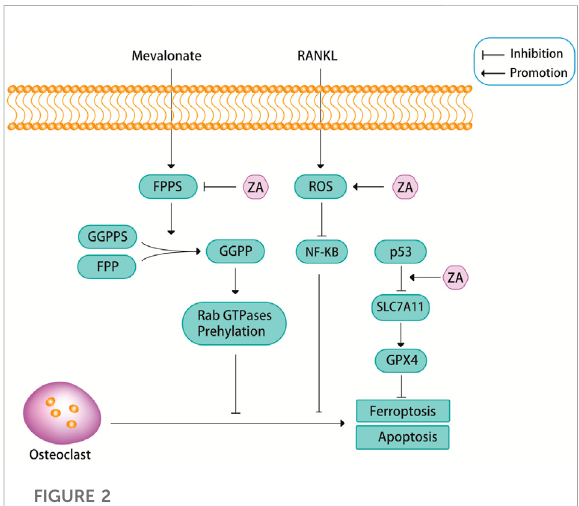
FIGURE 2 ZAcaninhibitthemevalonatepathway.Farnesylpyrophosphate synthase (FPPS), as a key regulatory enzyme in the mevalonate pathway,canpromotetheformationofgeranylgeranyldiphosphate (GGPP) from geranyl pyrophosphate synthase (GGPPS) and farnesyl diphosphate (FPP), and GGPP can promote the prenylation of Rab GTPases, this pathway is closely related to the apoptosis of osteoclasts. ZA promotes osteoclast apoptosis by inhibiting the activity of FPPS. In addition, ZA can promote osteoclast apoptosis through reactive oxygen species (ROS). Recent fi ndings suggest that ZA may promote ferroptosis in osteoclasts through